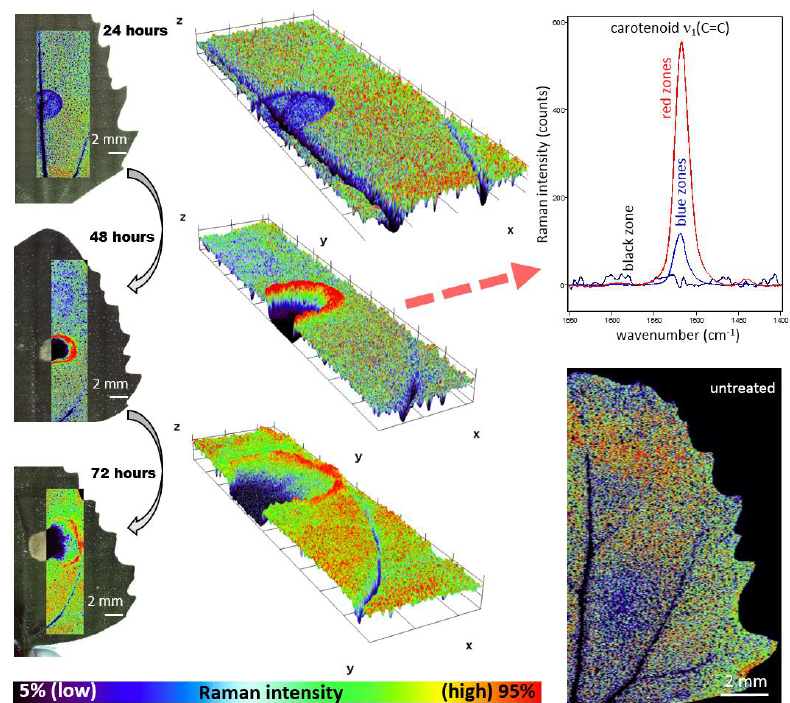
Figure 2. Distribution of Raman signal-to-baseline intensity of the carotenoid ν 1 (C = C) band in leaves of Chenopodium album . The area around the herbicide application was scanned 1–3 days after application. The 3D plots represent a visualization of 2D spatial information, with z -axis representing the Raman intensity of the ν 1 (C = C) band. Sensors 2020 , 20 , x